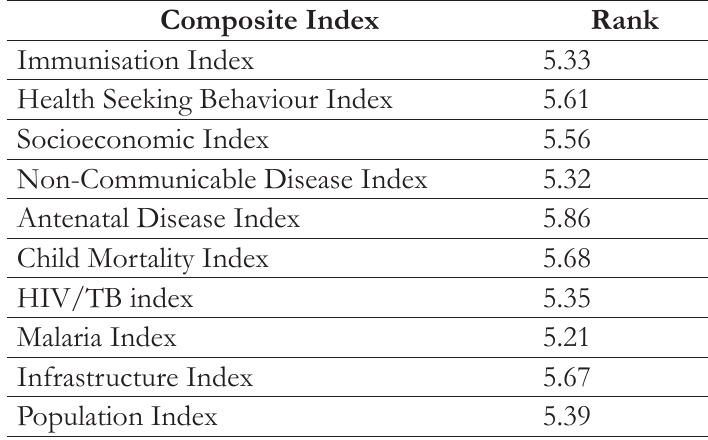
Table 4. Ranking Test for the 10 Composite